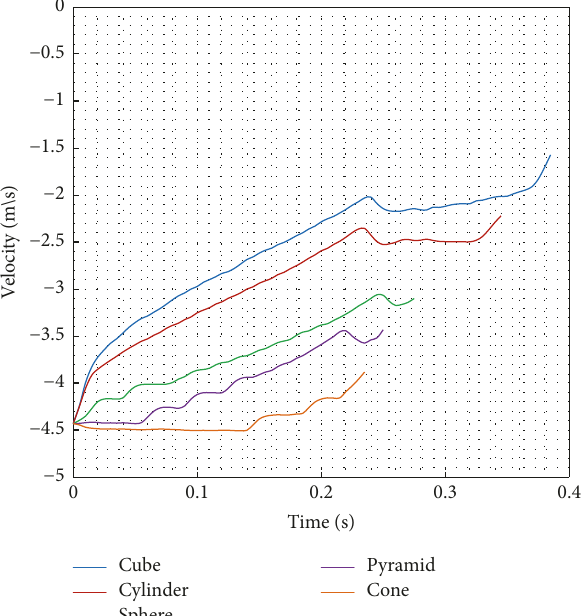
Figure 11: Velocity-time graph of pounders with different geometric shapes.